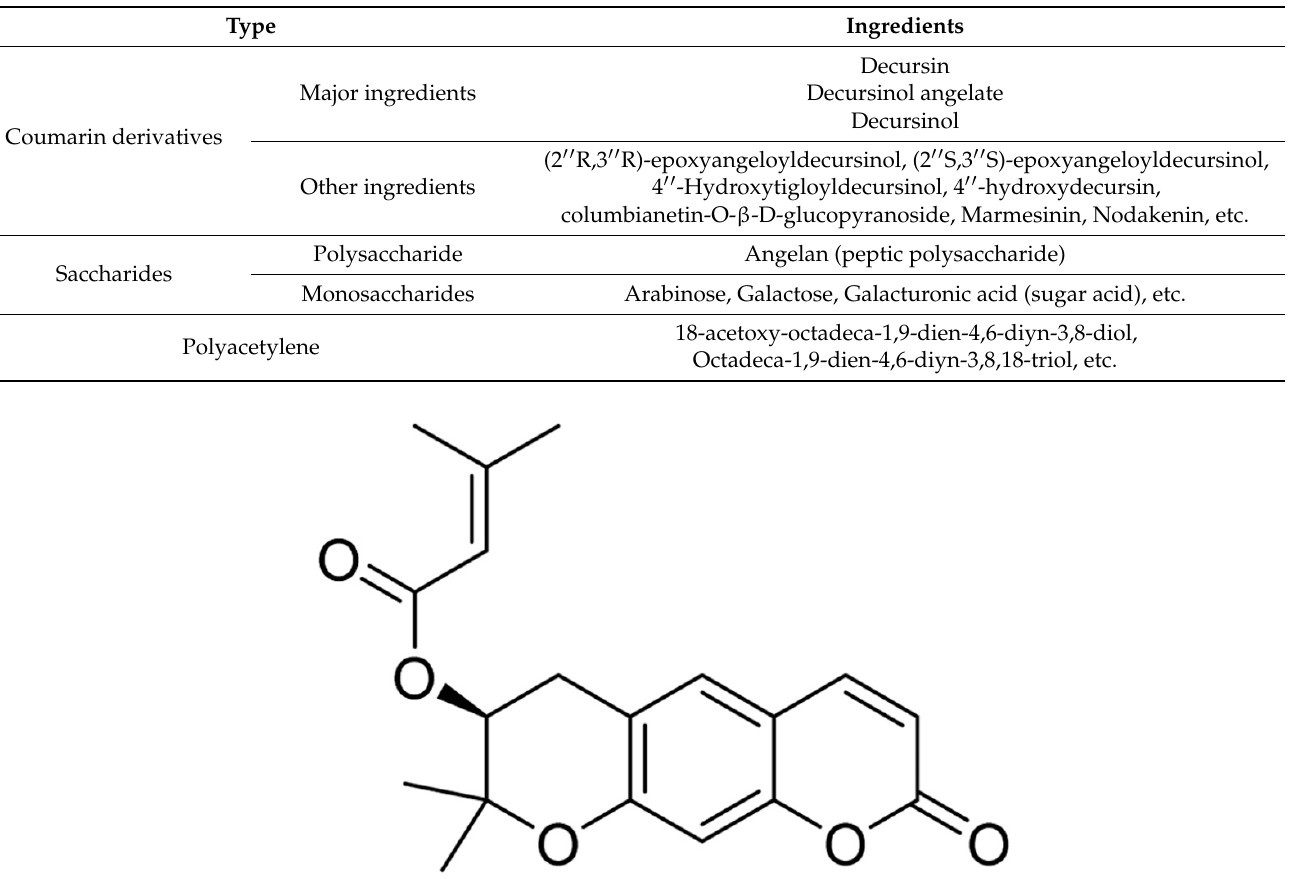
Table 1. Ingredients of Angelica gigas Nakai root extract (AGNE).